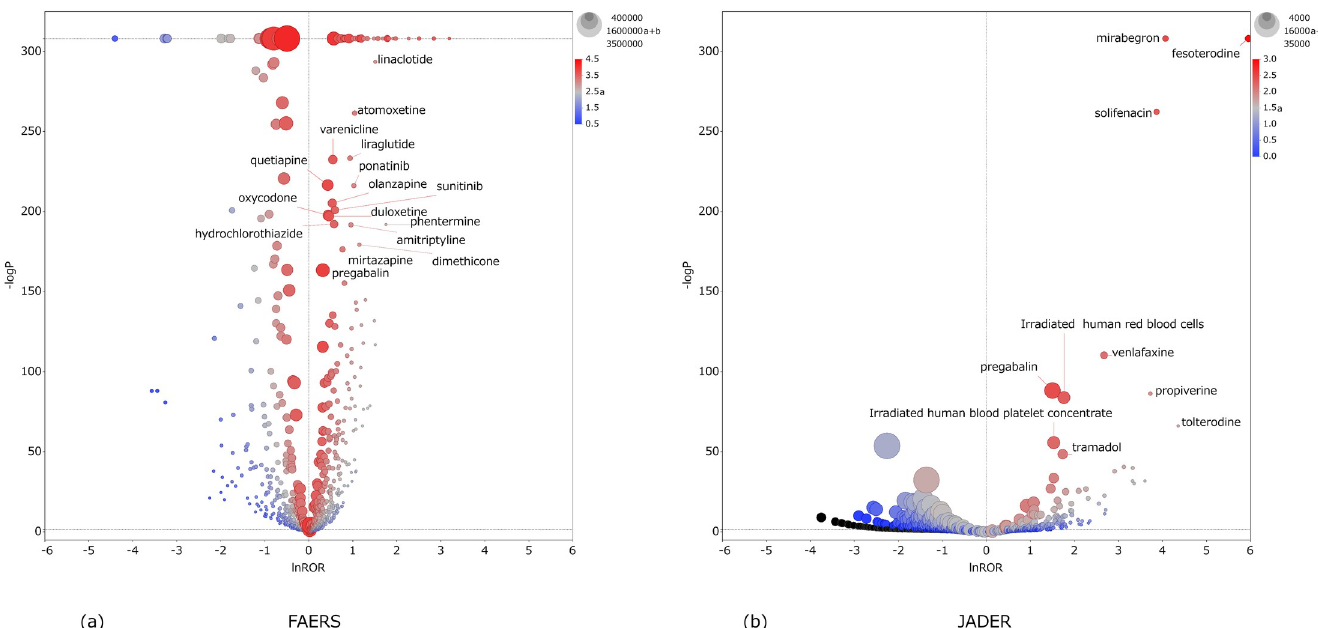
Fig 4. Scatterplot of PNS. Tendency of inducing PNS anticholinergic AEs by each drug. (a) FAERS and (b) JADER. gency table. The color of the dots indicates the number of cases of anticholinergic AEs of the drug: it is the value of “a” in the two-by-two table. Accordingly, drugs plotted in the top-right of the scatterplot and in red are the major suspected drugs. Tables 2–4 show the major sus-